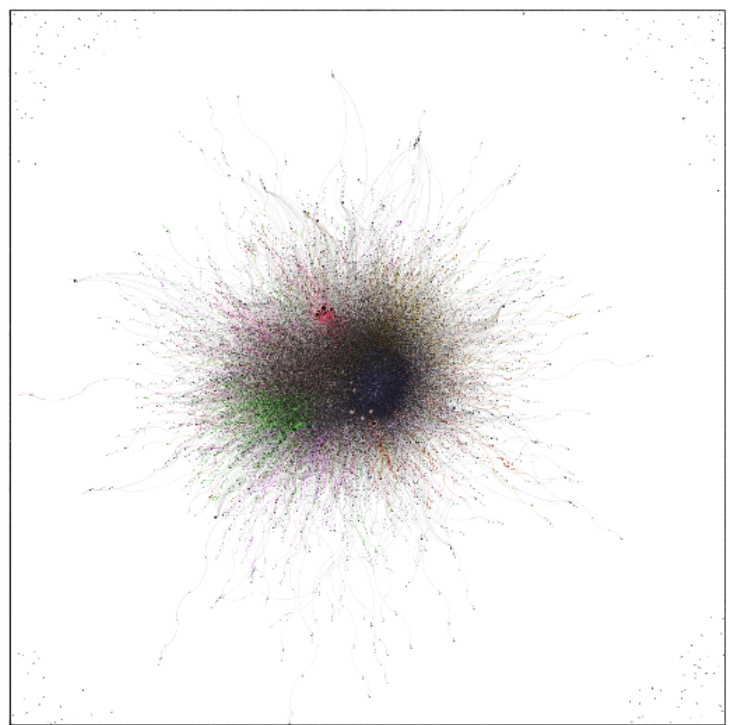
Figure 1. Analysis of the network topology for the #Brexit Network suggests that there are powerful hubs in the network that facilitate connections between a large volume of less connected users.